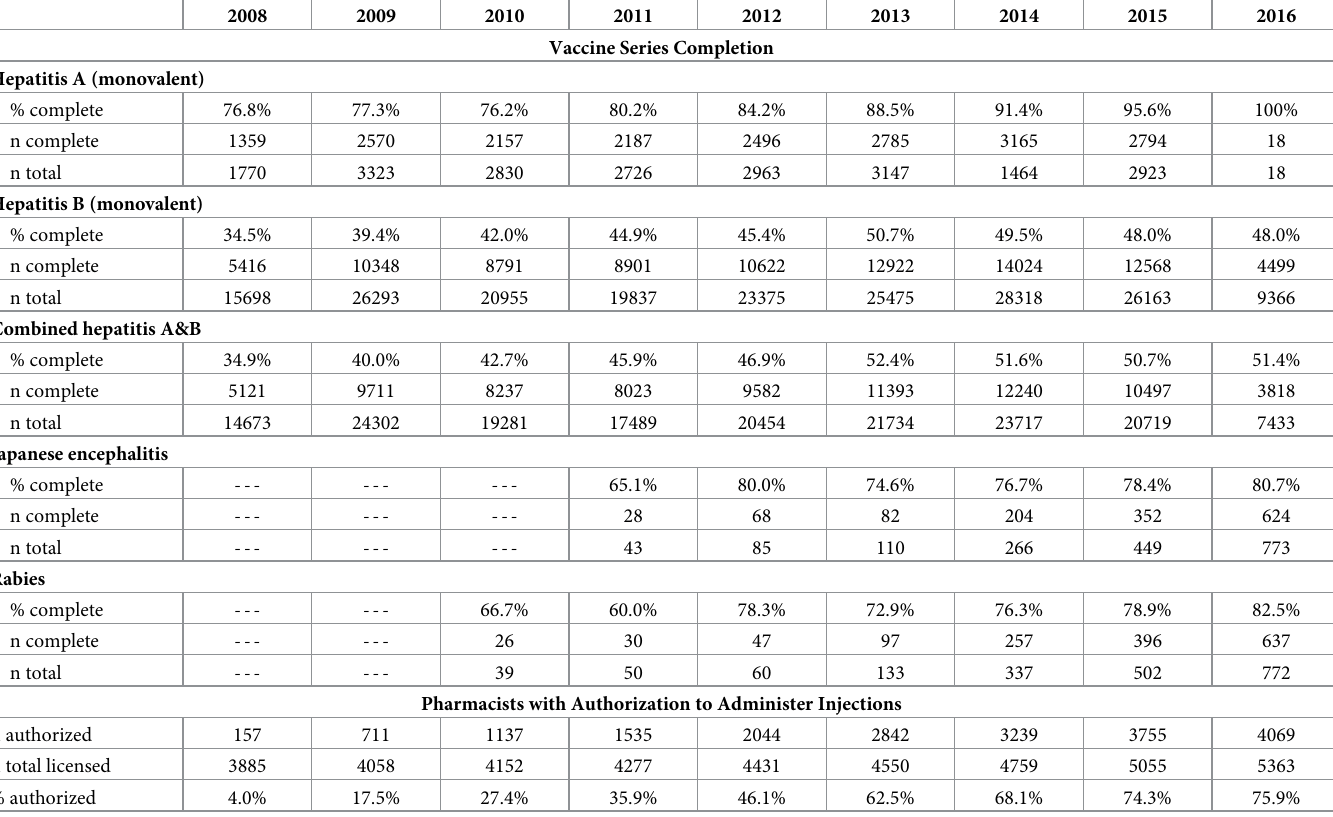
Table 2. Completion status of vaccine series based on year of incident prescription, and number and proportion of pharmacists authorized to administer injections per